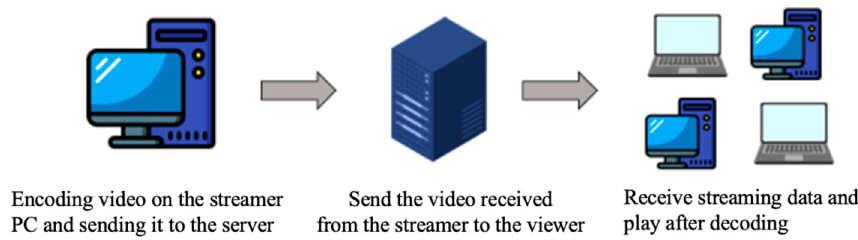
Figure 4. Streaming service data transmission path.